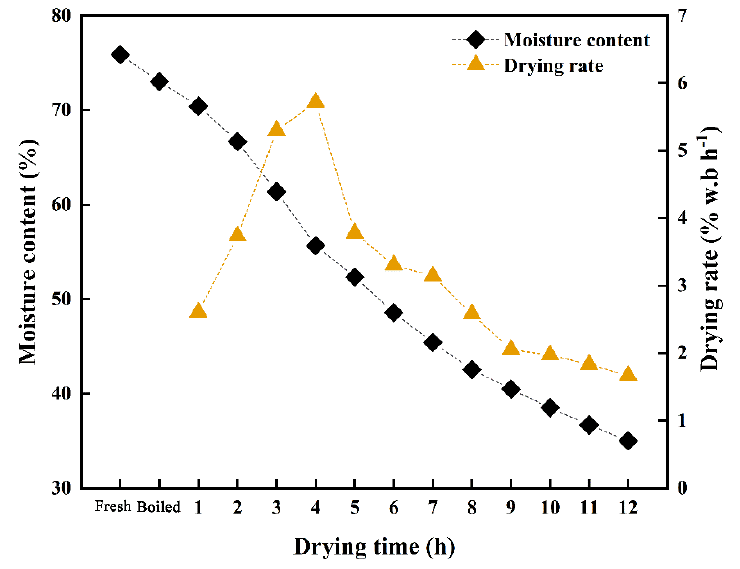
Figure 2. Averaged measured moisture contents of all samples at different drying levels.